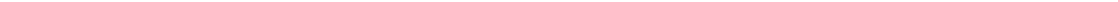
Fig. 6 A proposed model of HyPer-Low subpopulation of CCA cells with relative high expression of MTHFD1 impairs Gemcitabine-induced apoptosis in